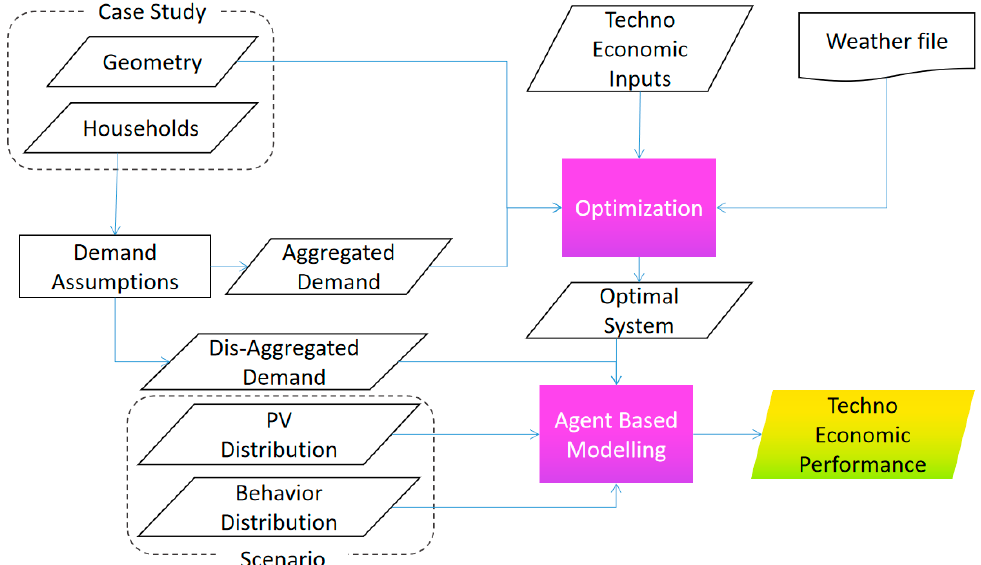
Figure 1. Flow diagram of the data and operations performed for this study .